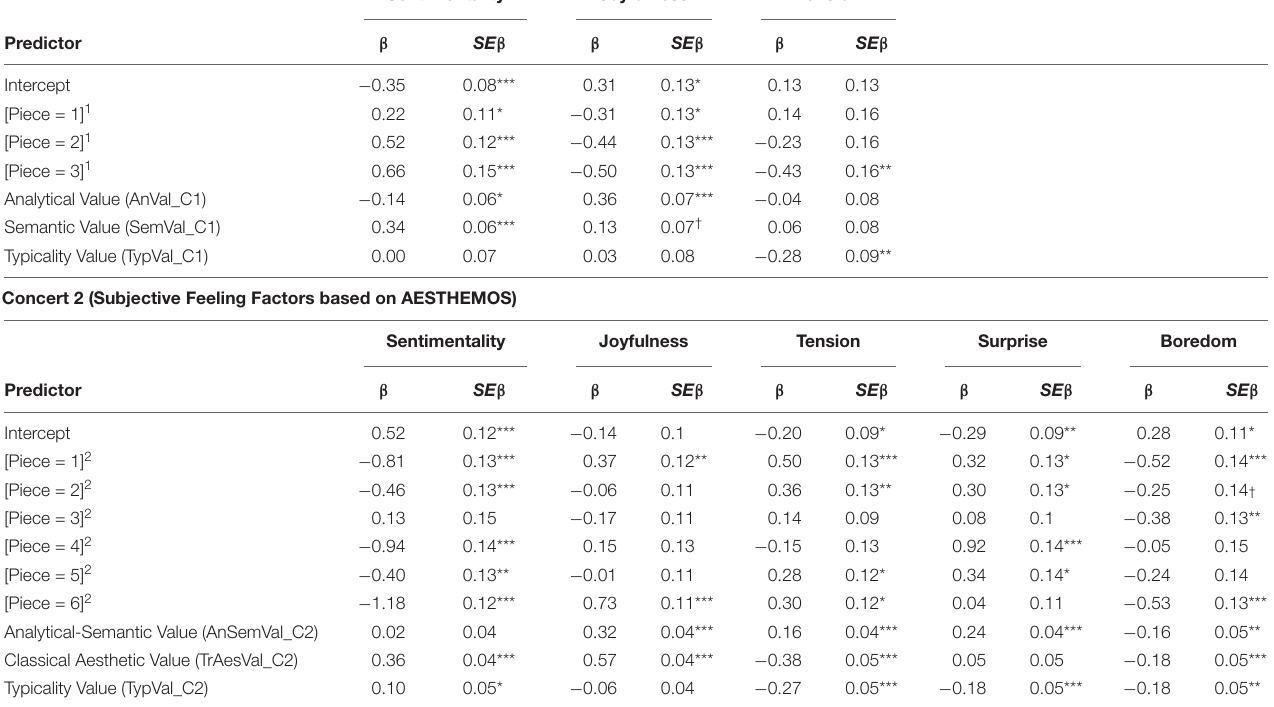
TABLE 8 | Hierarchical linear models of aesthetic judgment value factors and pieces of music as predictors of subjective feeling factors. Concert 1 (Subjective Feeling Factors based on GEMS) Sentimentality Joyfulness